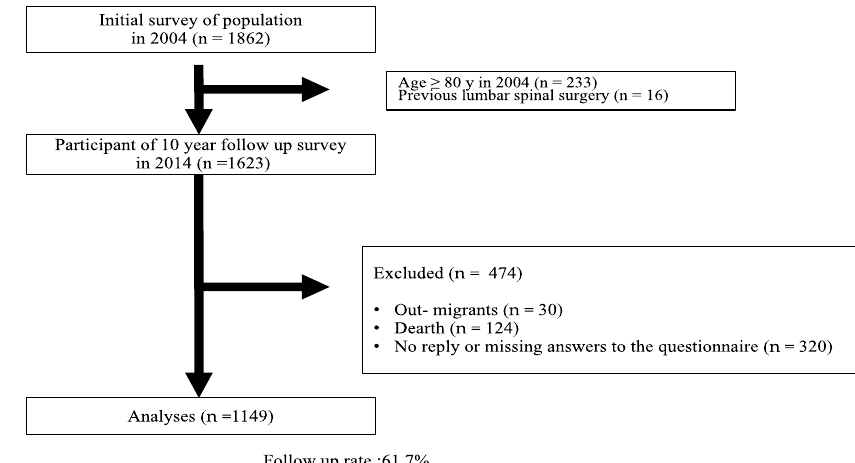
Figure 1. Registration protocol of the questionnaire.